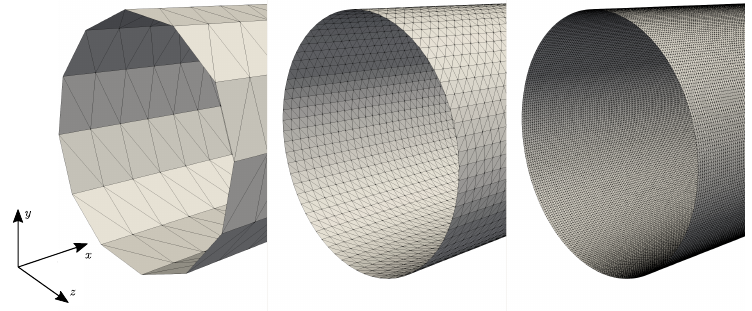
Figure 6. STL triangulations of the pipe wall, left to right: D c / ∆ c t = 6,24 and 96. Simulations are run for D c / ∆ x = { 6, 12, 24, 48, 96 } and D c / ∆ c t = { 6, 12, 24, 48, 96 }